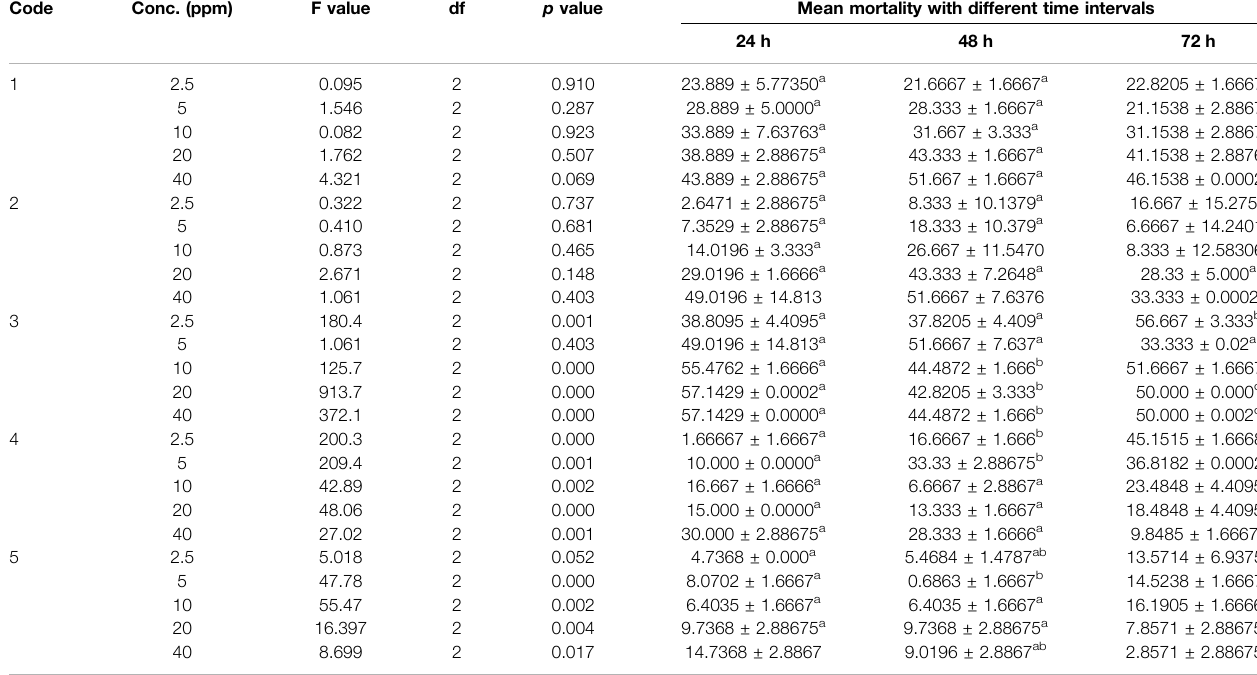
TABLE 1 | Mean mortality of house fl y ( Musca domestica L.) larvae after 72 h of exposure to 30% concentration of insecticides. Code Conc.